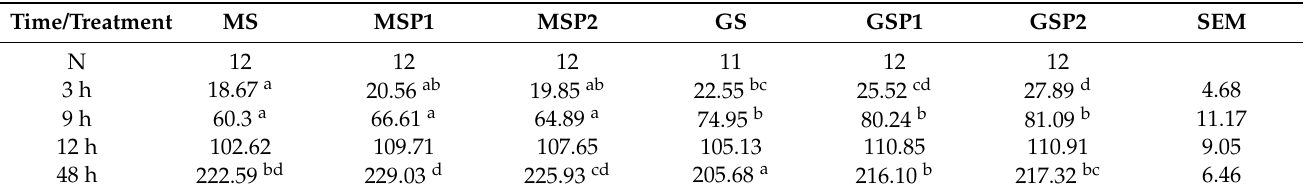
Table 4. Total gas production (mL gas at STP per gram organic matter) at a chosen time points during fermentation of grass or maize silage with or without probiotic 1 (P1) or probiotic 2 (P2) (pooled data from 2